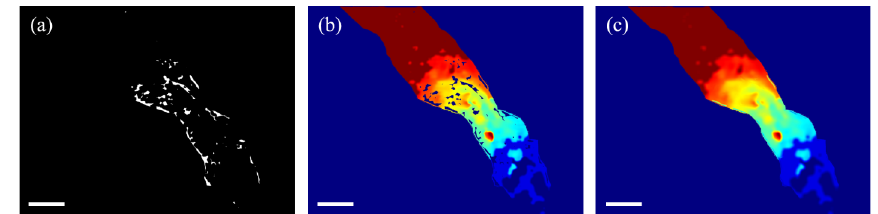
Fig. 13 Process of obtaining a complete depth map. (a) Noise mask diagram, (b) Depth map with noise removed, (c) Complete depth map recovered using the estimated depth values. The scale bars in these pictures are 10